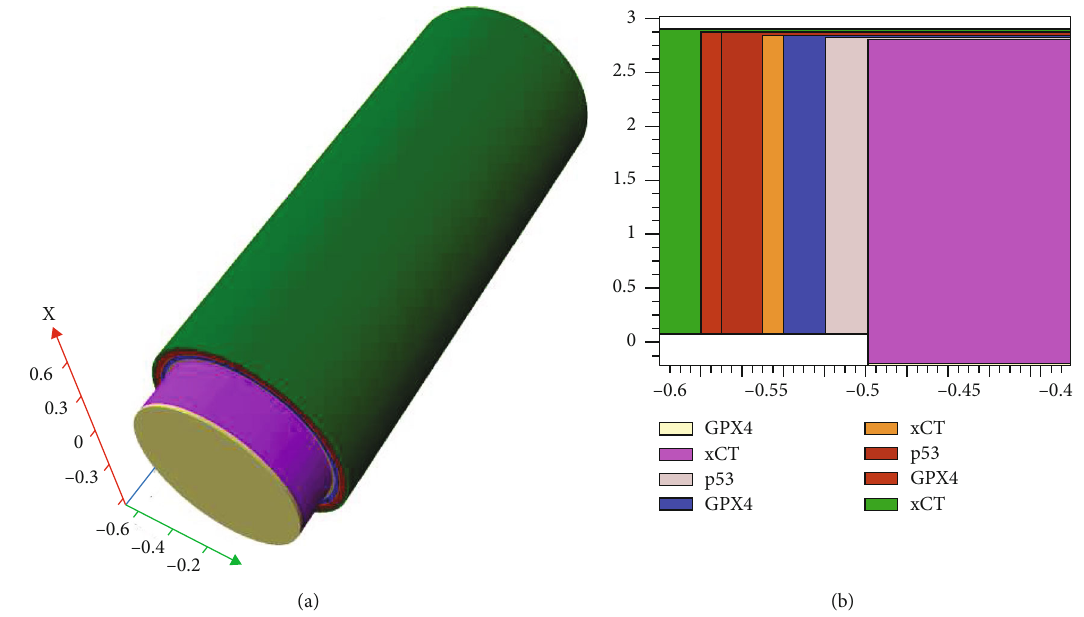
Figure 3: Graphic representation of the three-dimensional model of the solar cell (a) and an enlarged section of the wall side